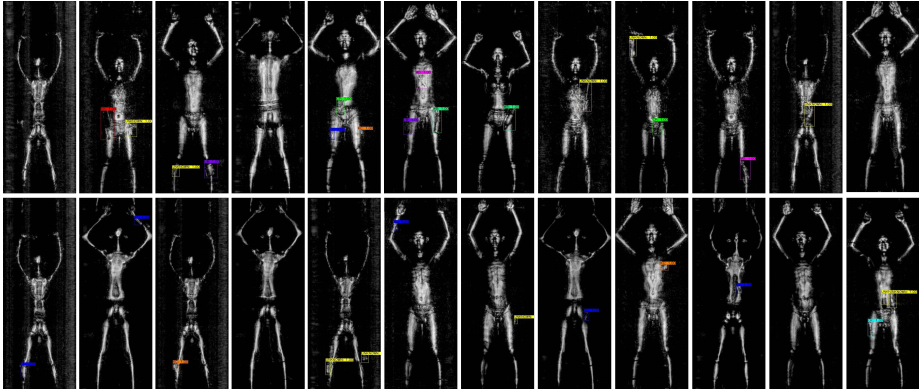
Figure 7. Example of general examples (first row) and hard examples selected by HEM (second